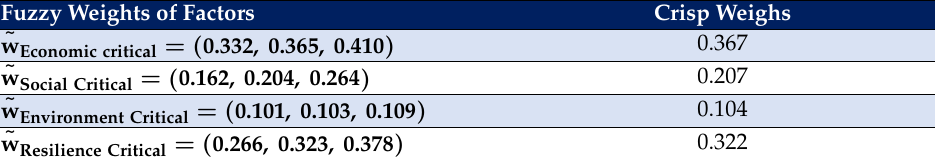
Figure 6. Asset criticality index for key physical assets in GP. PA stands for physical assets. Table 12. Fuzzy weights of factors. Fuzzy Weights of